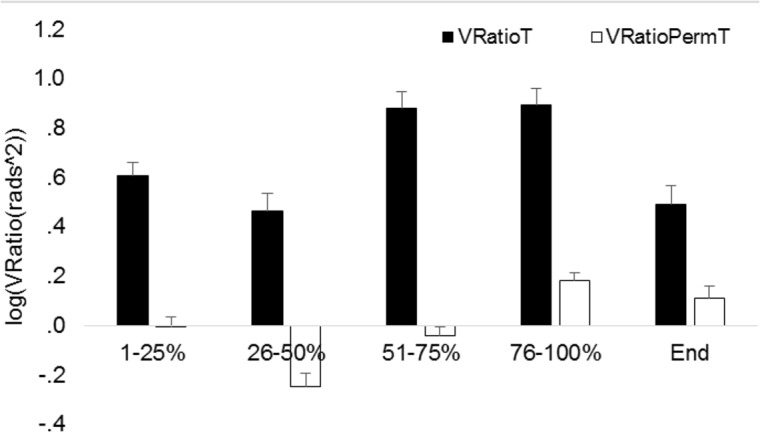
Log transformed VRatio (VRatioT) and VRatioPerm (VRatioPermT) averaged across ID and physical demand conditions for all phases of the reaching movement and at the end-point of reaching.Vertical bars denote standard error of the mean.